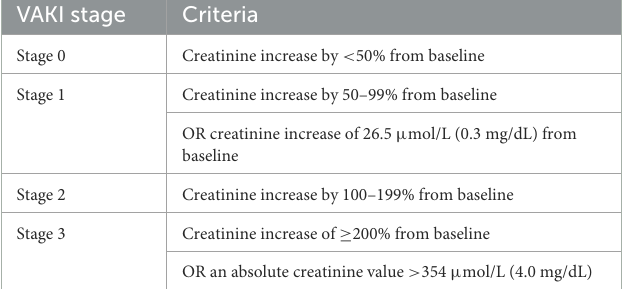
TABLE 1 Criteria of different stages of the VAKI scoring system